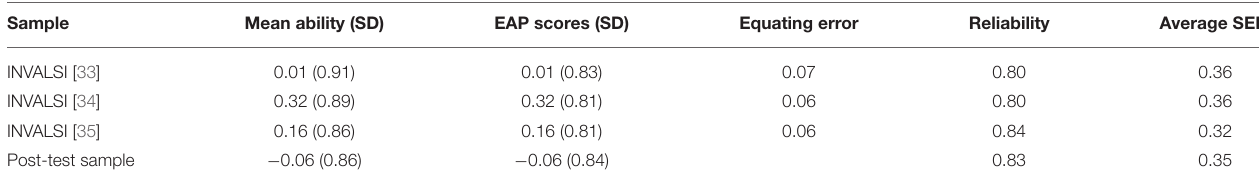
TABLE 3 | Concurrent calibration equating: distribution of the ability scores and estimated equating errors.